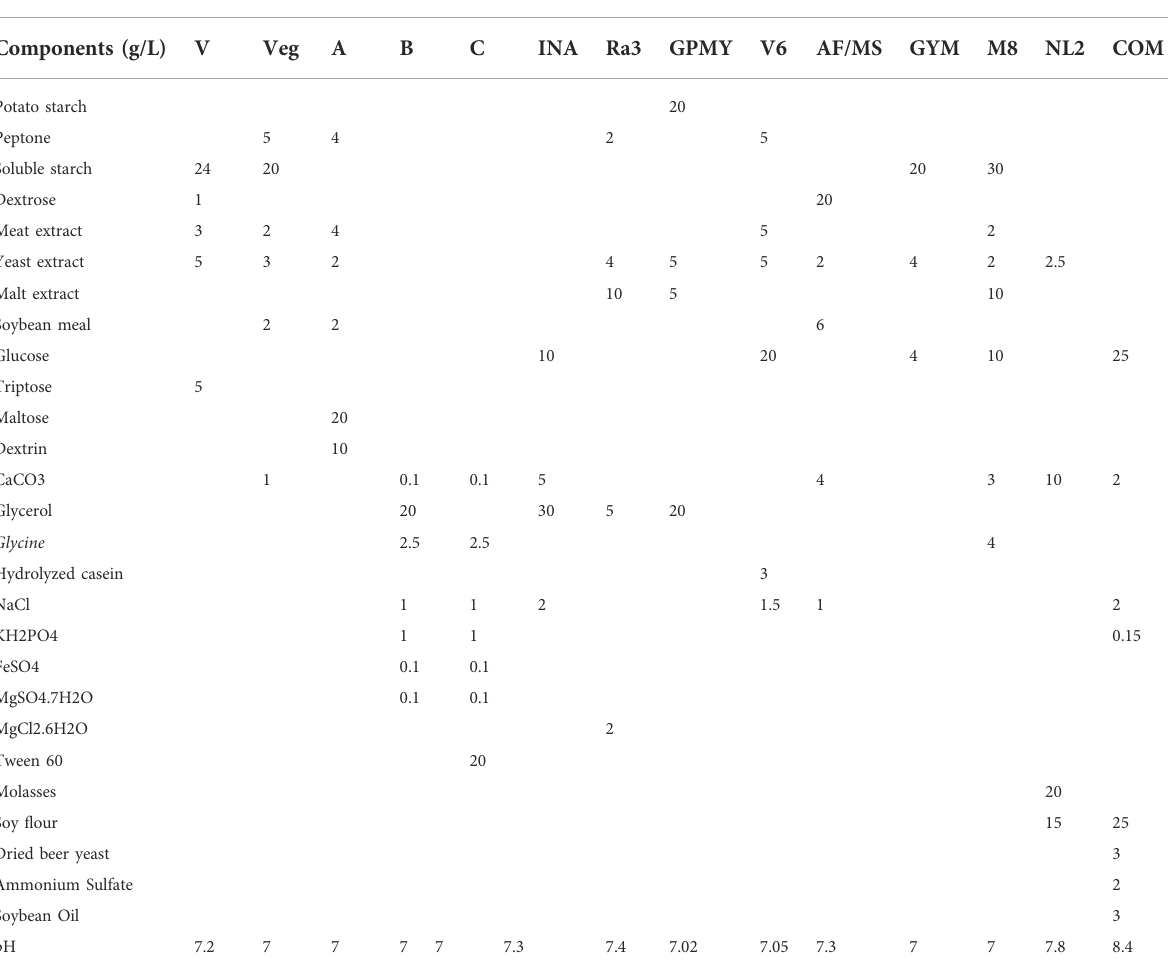
TABLE 1 Composition of the 14 different production